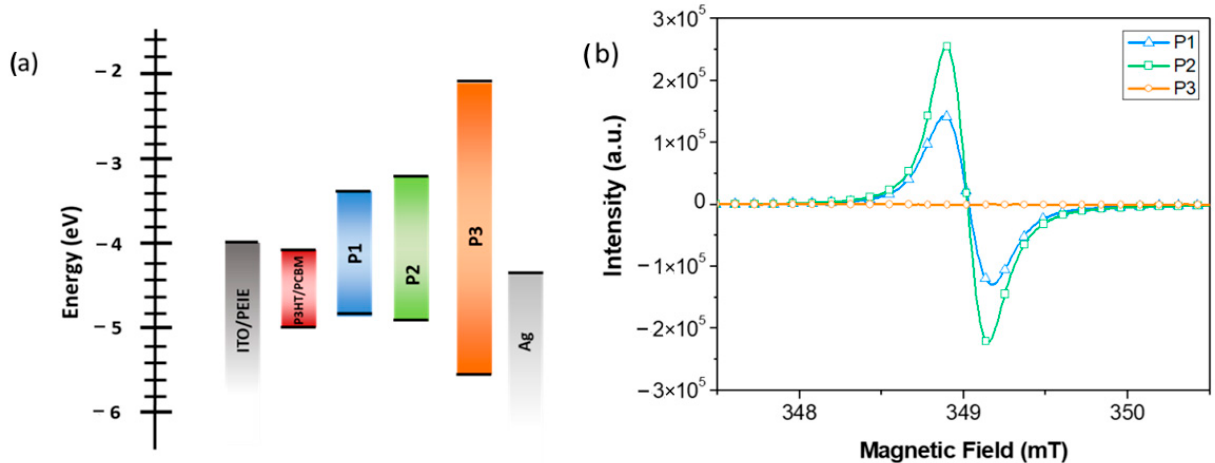
Figure 2. ( a ) Energy level of the materials used to fabricate inverted solar cells in this contribution; and ( b ) electron paramagnetic resonance (EPR) spectra of P1 , P2 , and P3 in aqueous solution.